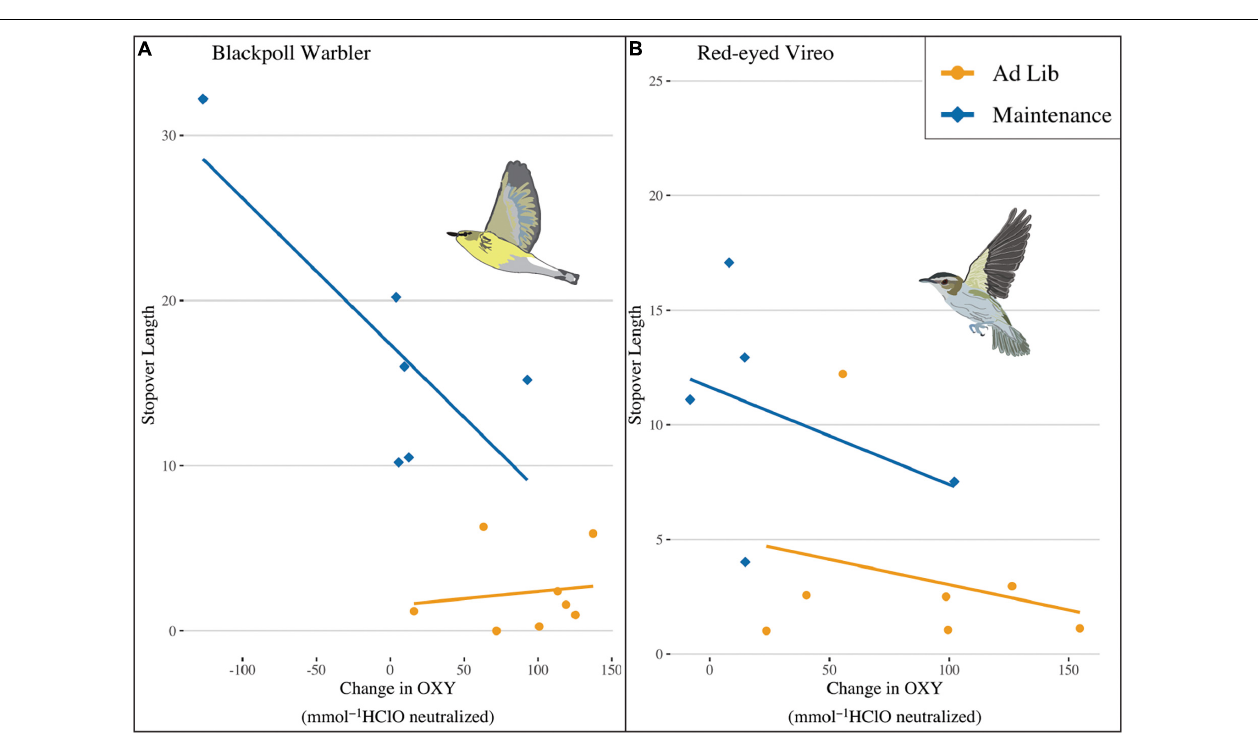
molecules, precursors for enzymatic antioxidants) while building fat stores (Tsahar et al., 2006; Costantini, 2011; Carro et al., 2012; Skrip and McWilliams,